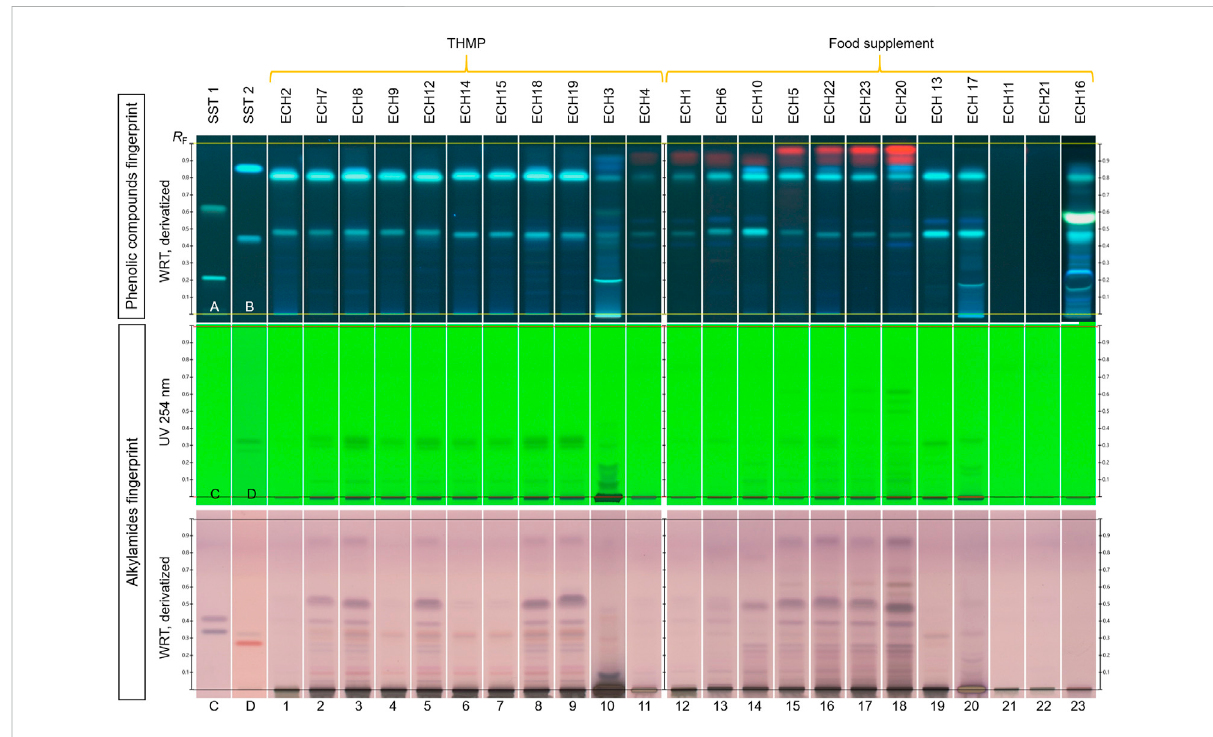
FIGURE 4 Alkylamide fi ngerprints of standards and Echinacea spp. products, in different detection modes. Tracks (A) echinacoside and cynarin, (B) chlorogenic and caffeic acids, (C) Ursolic acid and β -sitosterol and (D) dodeca-2E,4E,8Z,10E/Z-tetraenoic acid isobutylamide and dodec-2-ene- 8,10-diynoic acid isobutylamide (with increasing R F ); 1 – 23: ECH products 1 – 23.